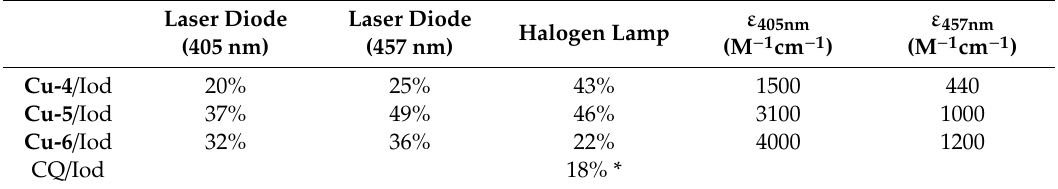
Table 1. TMPTA conversions determined in laminate for two-component systems Cu-x(x = 4–6) / Iod (0.2% / 2% w / w ) upon irradiation at di ff erent wavelengths for 500 s and light absorption properties at the emission wavelengths of the di ff erent light sources (extracted from the work in [80]).